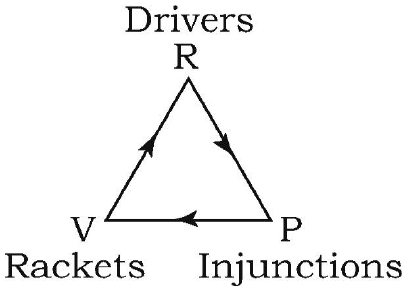
Figure 13: The Miniscript Drama Triangle Five Split-Level TA Teaching Triangles